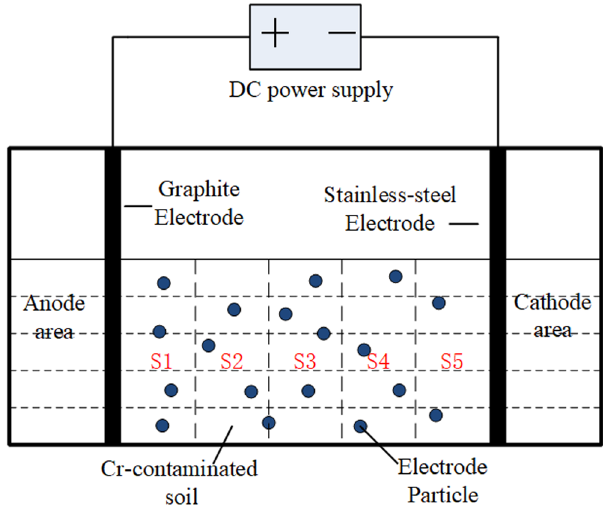
Figure 1. Schematic diagram of the EKR experimental device.